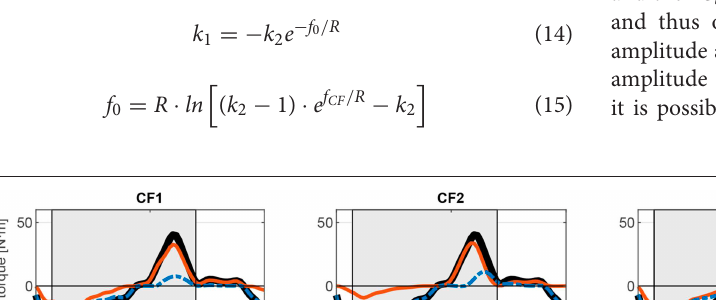
Frontiers in Neurorobotics |